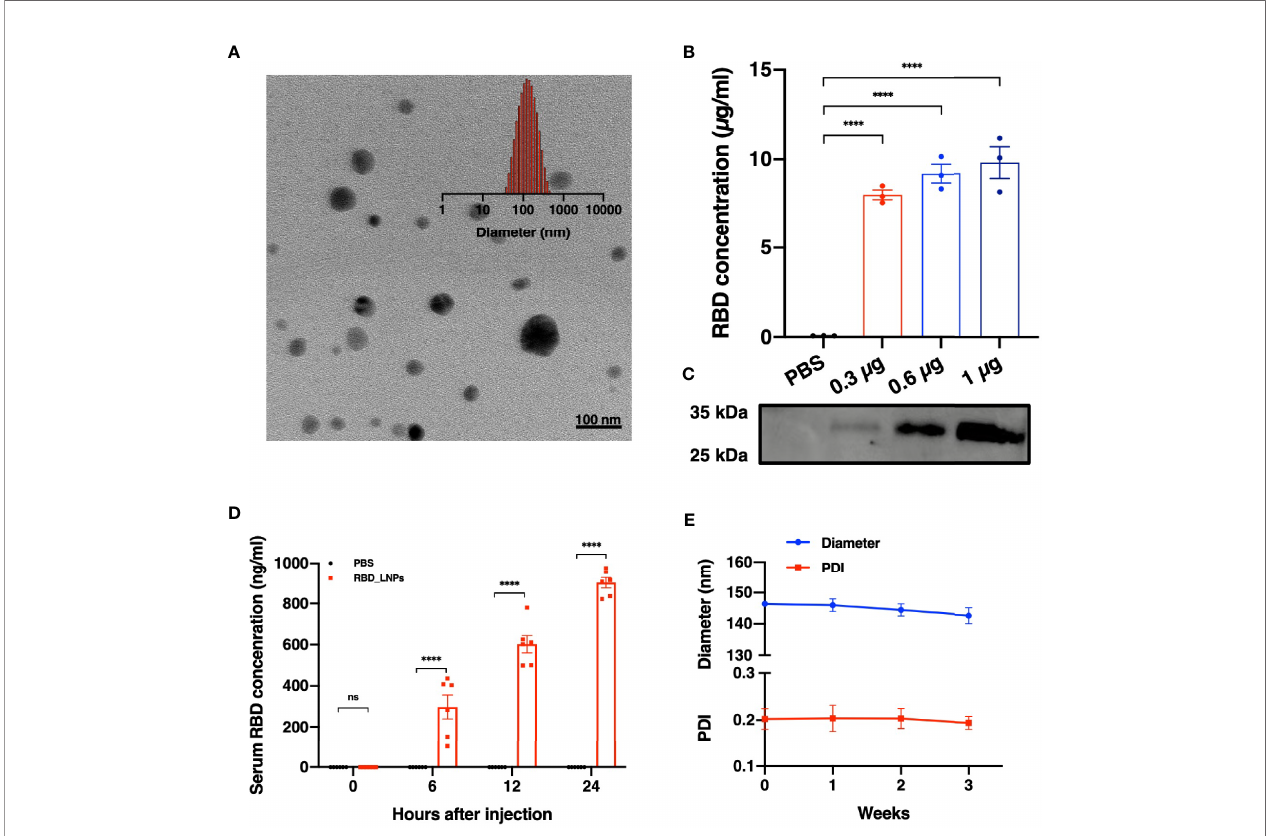
FIGURE 1 | Characterization, expression in vitro and in vivo delivery of RBD mRNA vaccine. (A) TEM and DLS results of RBD_LNPs. (B) RBD expression in HEK293T cells. Cells were transfected with RBD_LNPs at different amount of mRNA (0.3µg, 0.6µg, and 1µg/10 6 cells). The concentration was measured by ELISA at 72 h after transfection. (C) HEK293T cells were transfected with RBD_LNPs and western blot of cell supernatant was performed at 72 h after transfection. (D) Expression of RBD in mice at different time point after injection. (E) DLS results of stability test of RBD_LNPs, which were stored at 4°C for three weeks and the diameter and PDI were evaluated by DLS. The data are presented as mean ± SEM. Signi fi cance was calculated using unpaired t test (ns, not signi fi cant; *p < 0.05, **p < 0.01, ***p < 0.001, ****p <